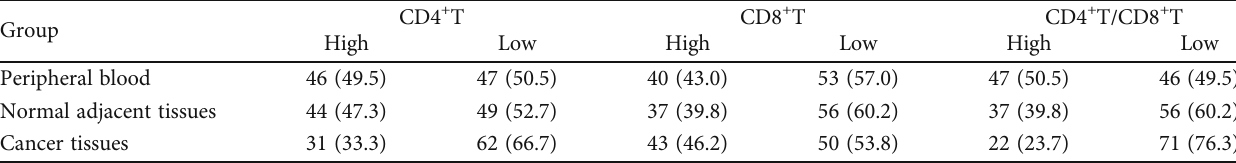
Table 3: Relationship between the levels of CD4 + T and CD8 + T in the peripheral blood to that of the carcinoma and normal adjacent tissues. CD4 + T CD8 + T CD4 + T/CD8 + T Group